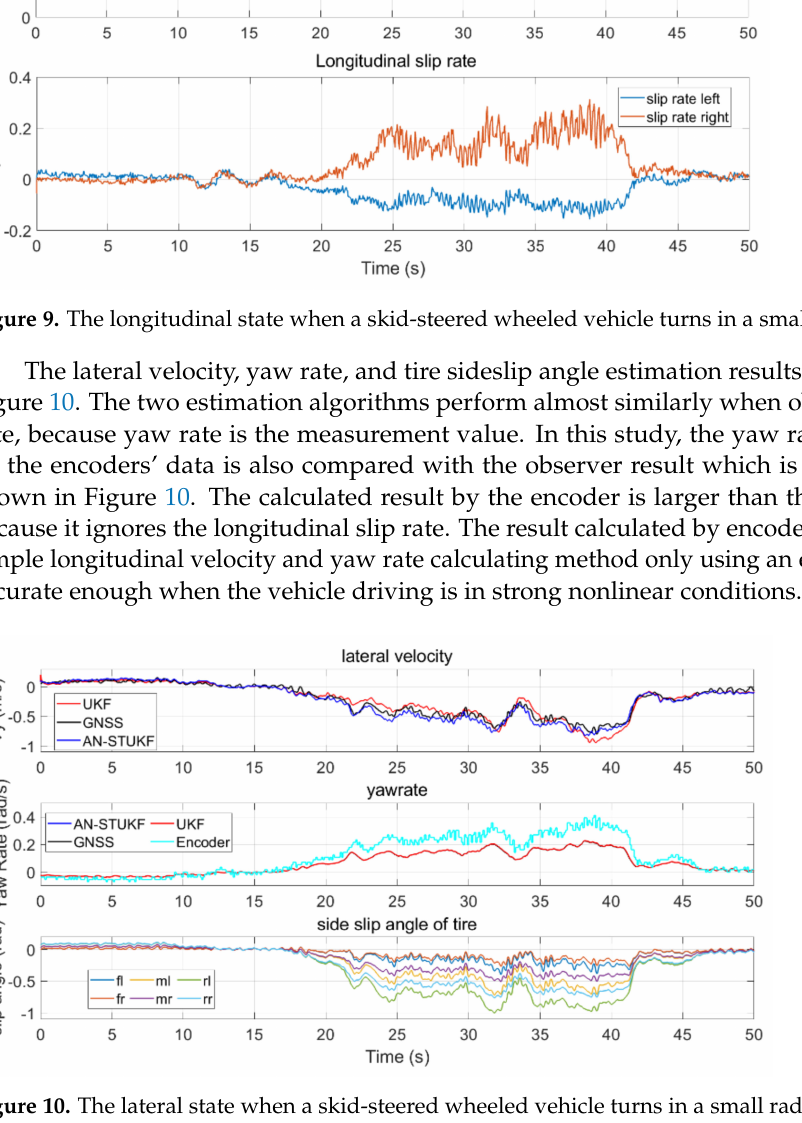
require the tire to work in a severe nonlinear condition, which creates difficulty in control. Figure 11 shows the tire marks of a skid-steered wheeled vehicle driving in turning and straight conditions. The tire is obviously skidding when the vehicle